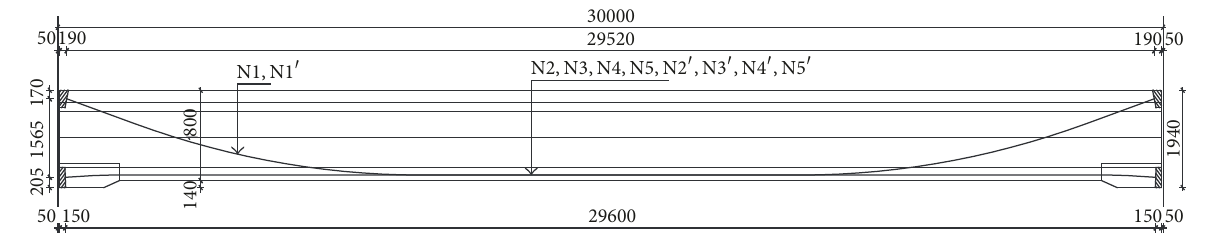
Figure 3: Elevation drawing and layout of the longitudinal prestressed steels in U-shaped girder (unit: mm).